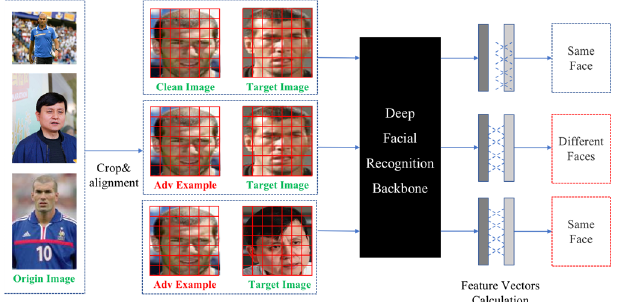
Figure 1. Face-based targeted attack and non-targeted attack diagram. The FRS could identify the first pair of images belonging to the same person but was unable to tell whether the face under attack was the same as the original person.